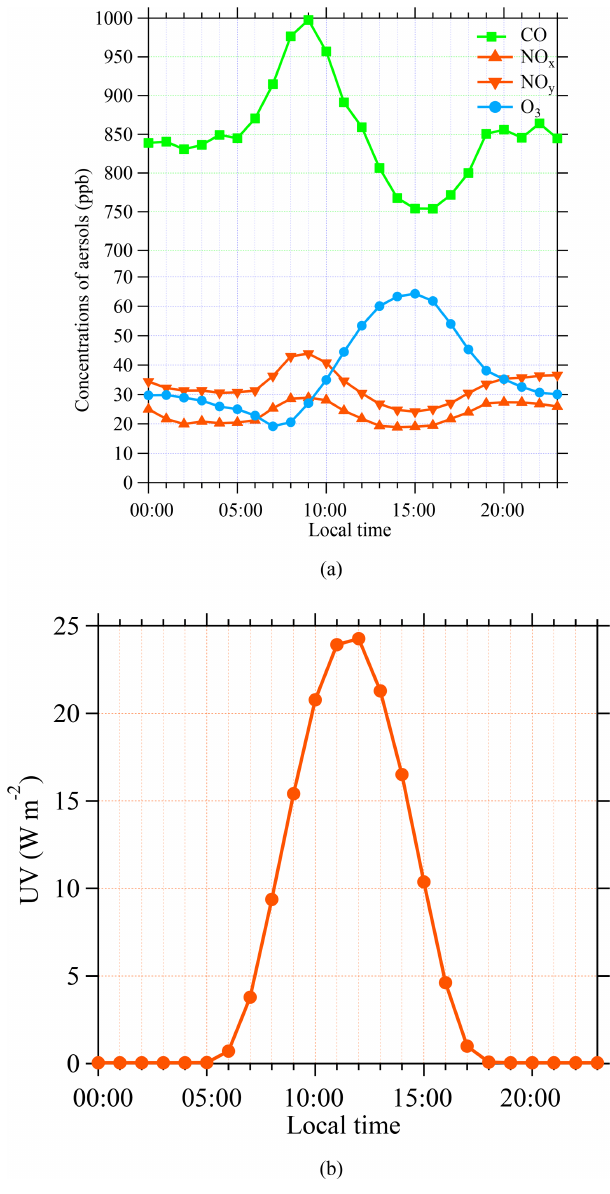
Figure 6. The 6-month mean diurnal variations of (a) trace gases and (b) UV at the Gulou site from September 2016 to Febru- ary